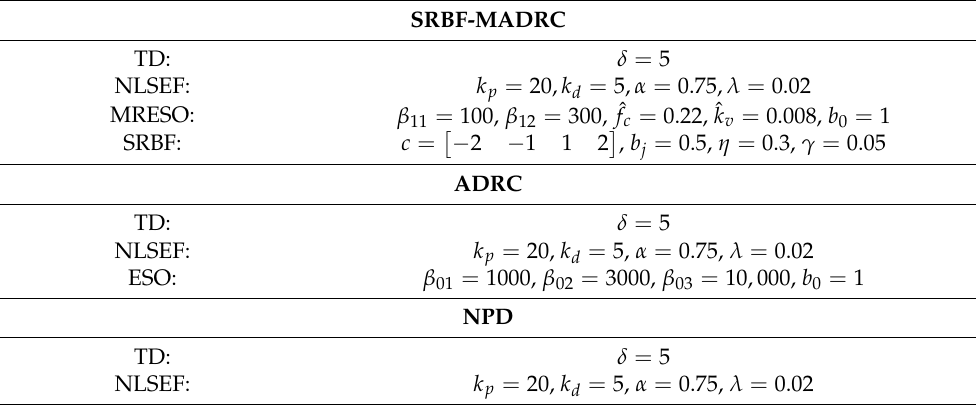
Table 1. Parameters of three control